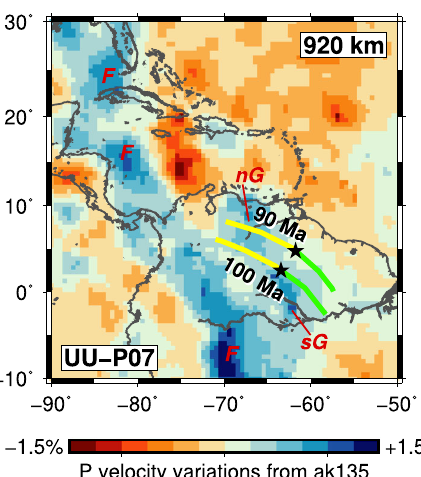
Fig. 7 Shallow lower-mantle structure with reconstructed trench positions. Slice at 920 km depth through tomographic model UU-P07 13, 31 . Red labels mark our interpretation of the high-velocity anomalies as derived from the subduction of: F Farallon, nG and sG northern and southern parts of the GAC. Coloured lines show our reconstructed positions of the trench at 90 and 100 Ma. The yellow lines (nG) and green lines (sG) indicate subduction to the northwest and southeast of the actively spreading Proto- Caribbean ridge (black stars),